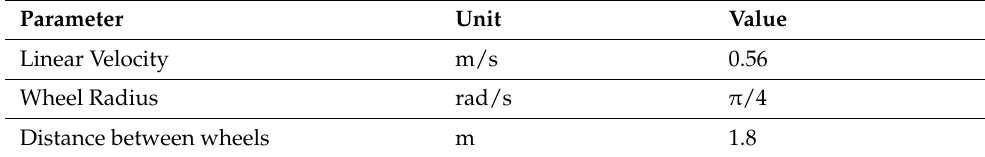
Figure 11. Field Trial Scenario with four-meter interval distance. Table 3. Parameters for MatLab